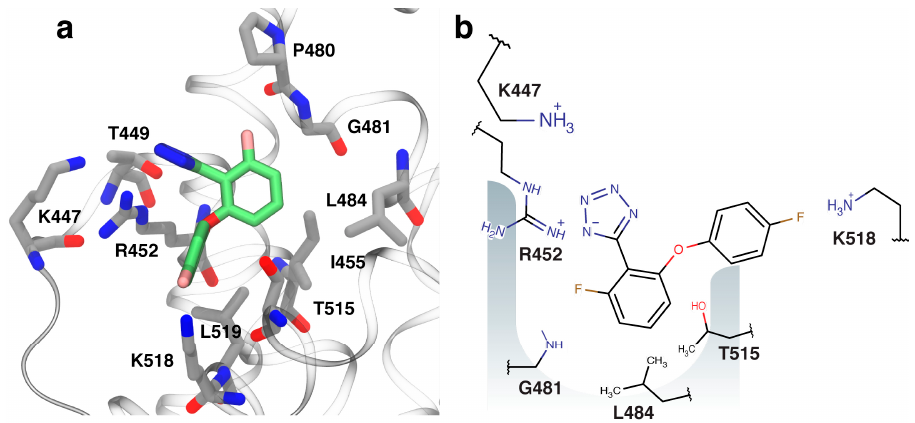
Figure 4. Visualization of binding of compound 5 . ( a ) The lowest energy binding poses of 5 (green carbon atoms) bound to DnaGC (gray carbon atoms). ( b ) Schematic representation of residues involved in interaction with compound 5 .